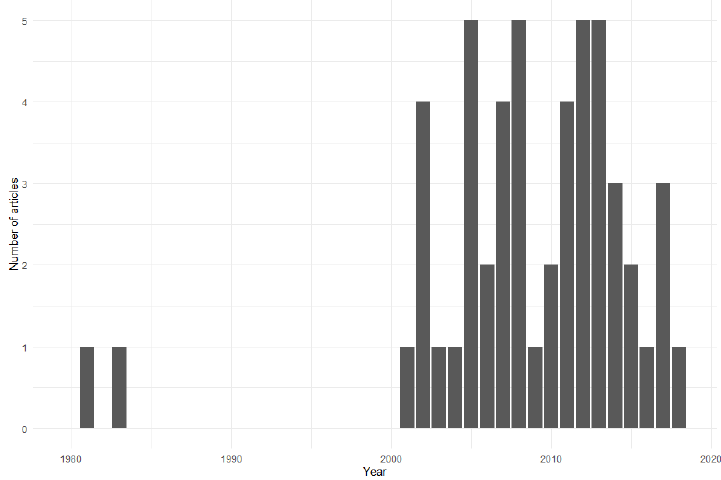
Figure A2. Year of publication of 52 articles that investigated the effect of nitrogen fertilisation on plant diversity on European permanent grasslands.